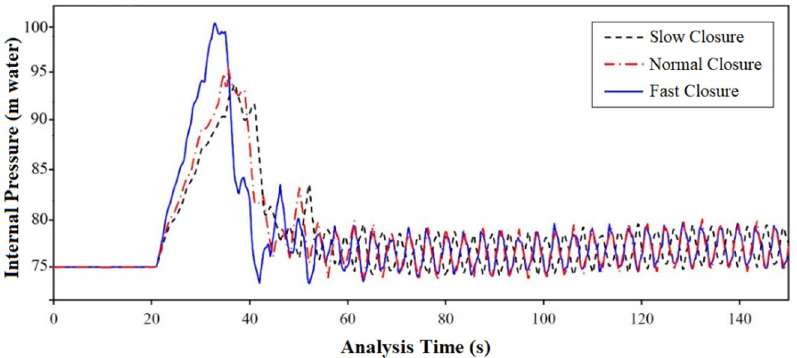
Figure 11. Pressure fluctuations upstream of the gate during the hydraulic analysis.